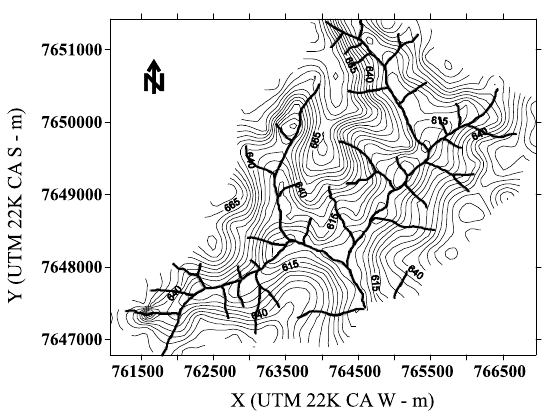
a qual é estimada por: